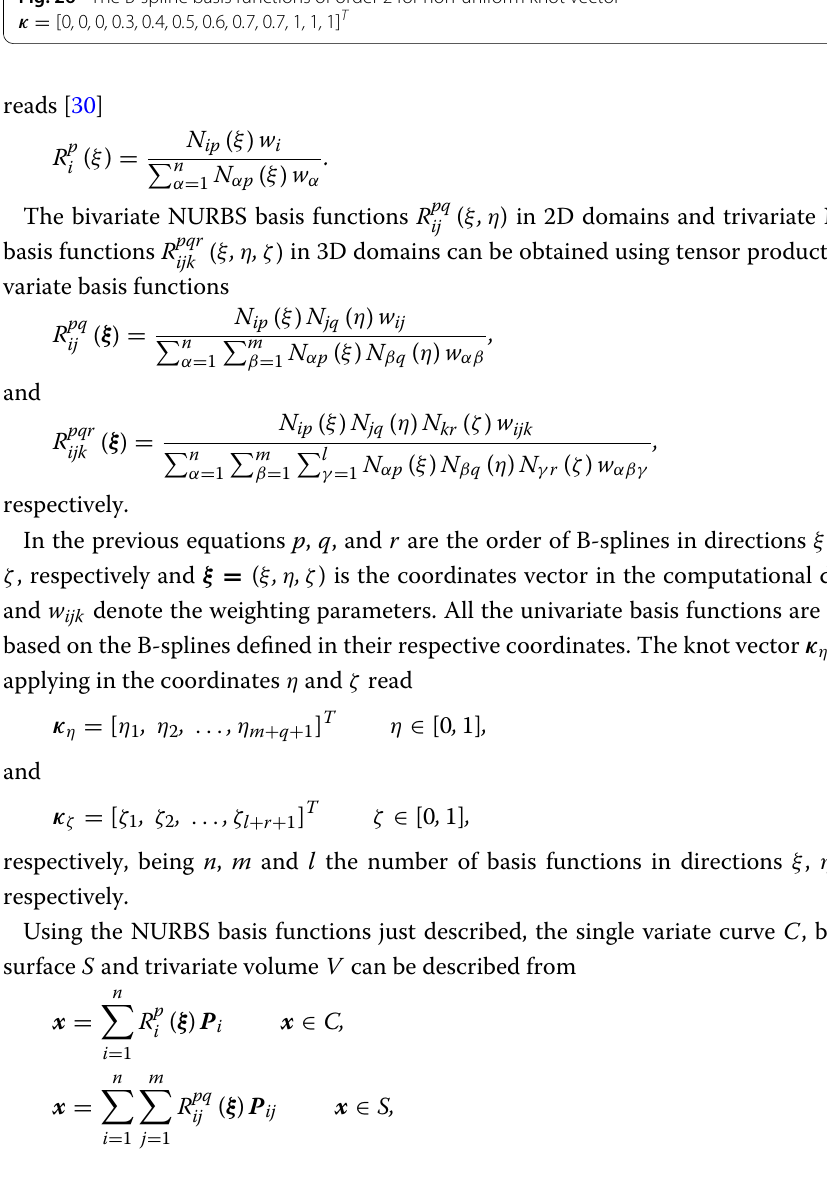
Fig. 26 The B-spline basis functions of order 2 for non-uniform knot vector κ = [0 , 0 , 0 , 0 . 3 , 0 . 4 , 0 . 5 , 0 . 6 , 0 . 7 , 0 . 7 , 1 , 1 , 1]